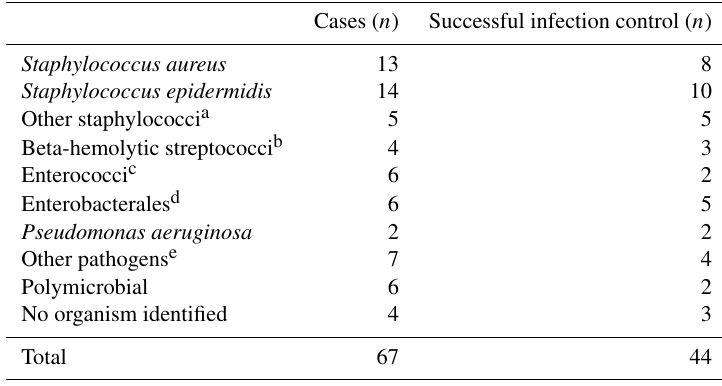
Table 2. Microbiology findings.